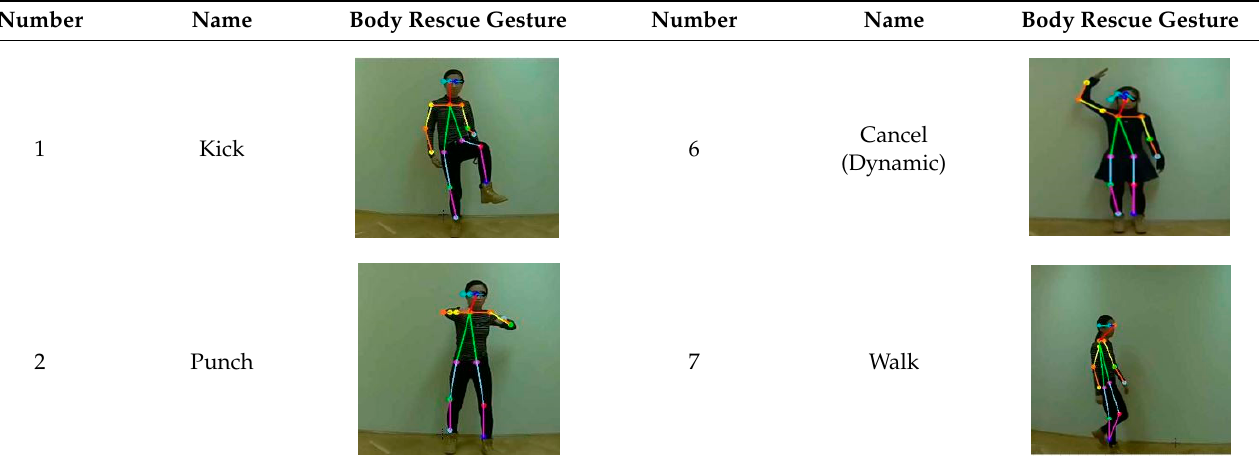
Table 3. UAV body rescue gestures and corresponding key points.